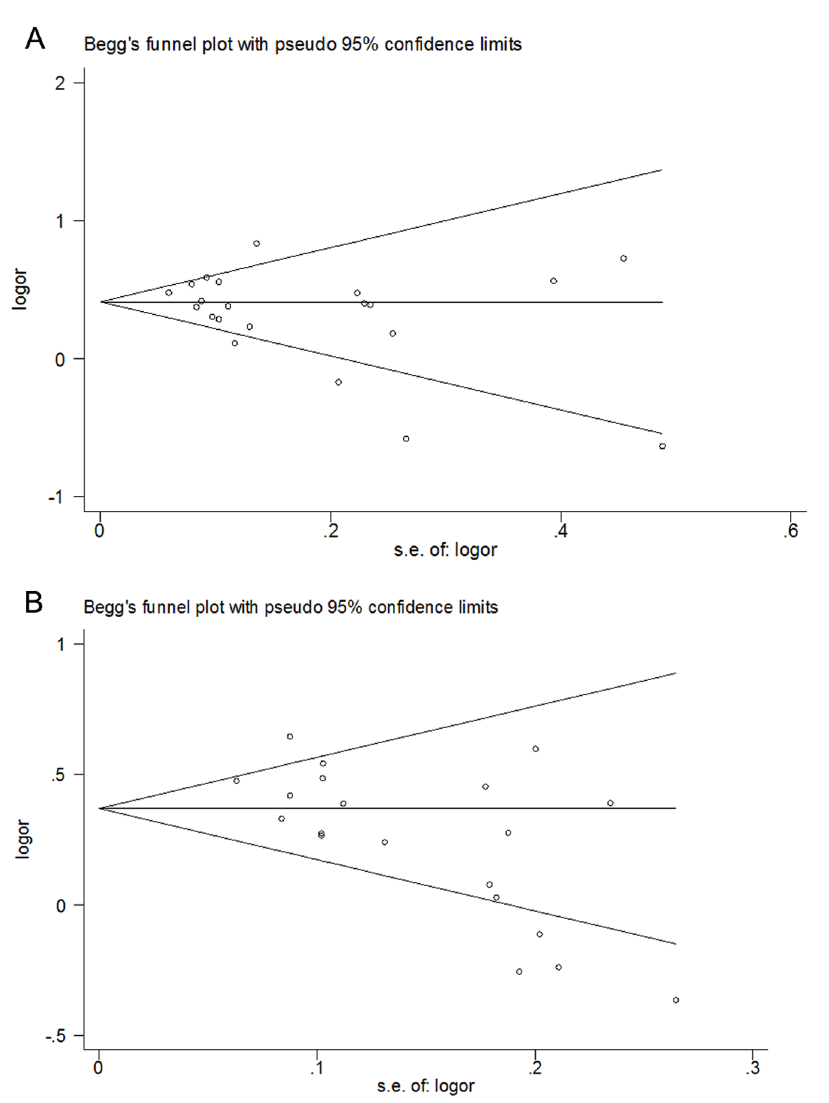
Figure 5. Publication bias in studies of the association between IKZF1 rs4132601 polymorphism and childhood AL risk assessed by Begg’s Funnel plot (G vs T). No significant funnel asymmetry was observed which could indicate publication bias. The horizontal line in the funnel plot indicates the random effects summary estimate, while the sloping lines indicate the expected 95% CI for a given standard error, assuming no heterogeneity between studies. Logor: natural logarithm of the